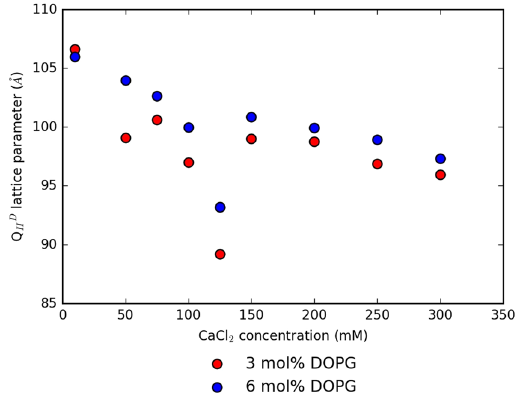
Figure 3. The effect of increasing the concentration of CaCl 2 used to hydrate the monoolein/DOPG system on the Q IID lattice parameter. 1D SAXS patterns from which the data were evaluated are in the Supplementary Information, Figure